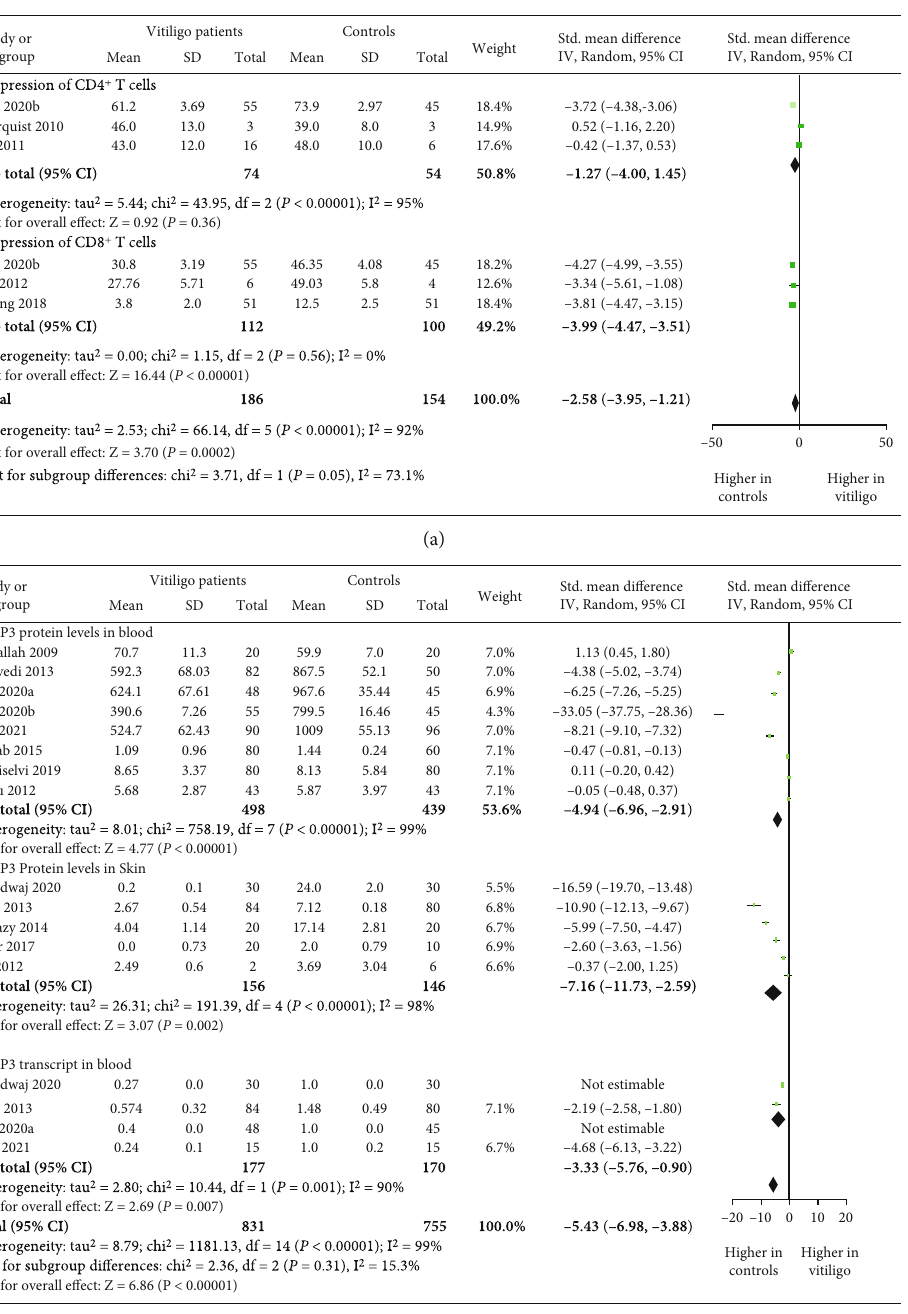
Test for overall effect: Z = 6.86 (P < 0.00001)